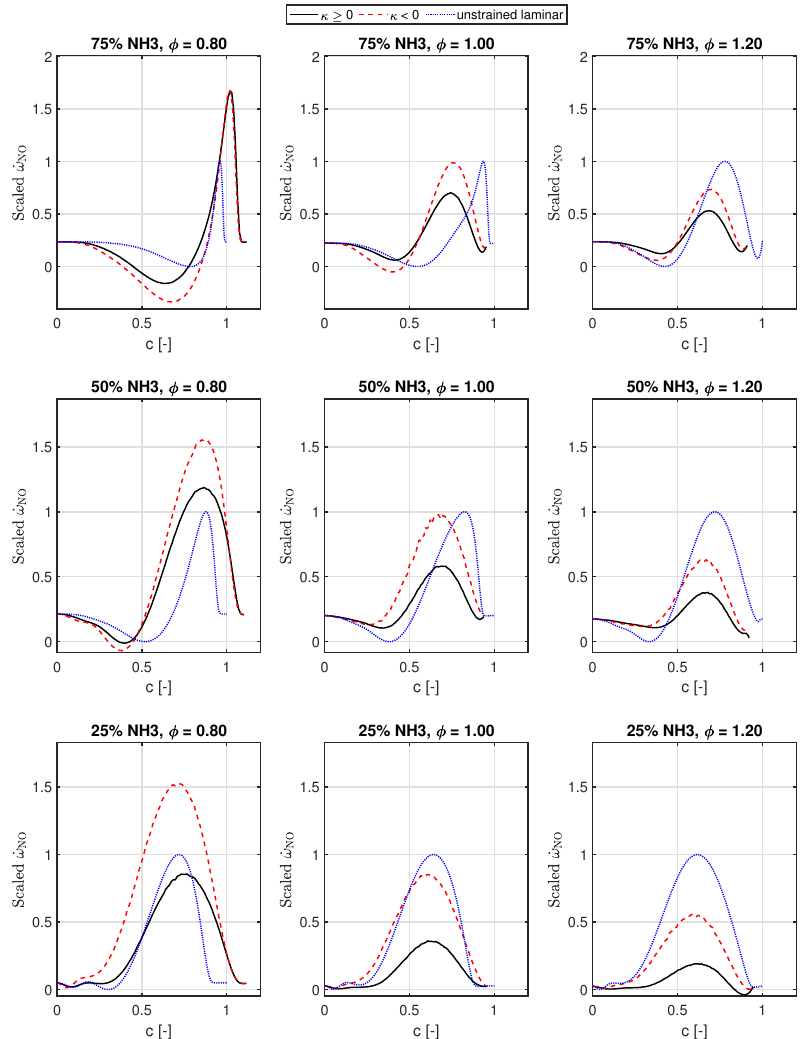
Figure 9. Conditional average of the source term of NO split by positive and negative curvature.